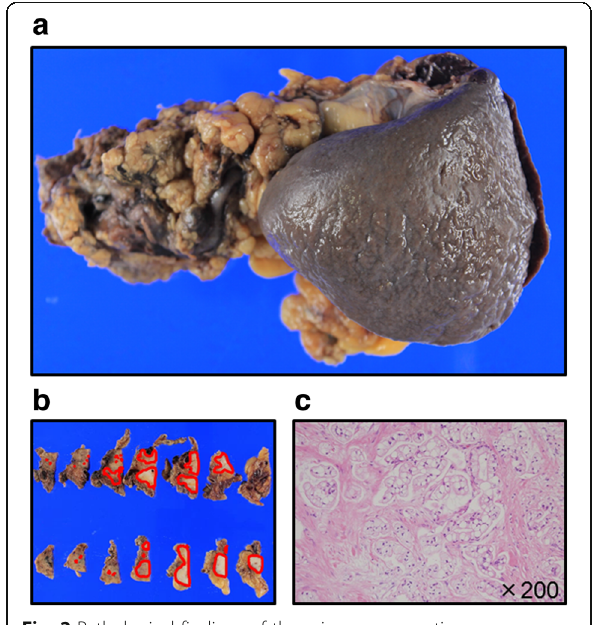
Fig. 2 Pathological findings of the primary pancreatic cancer.